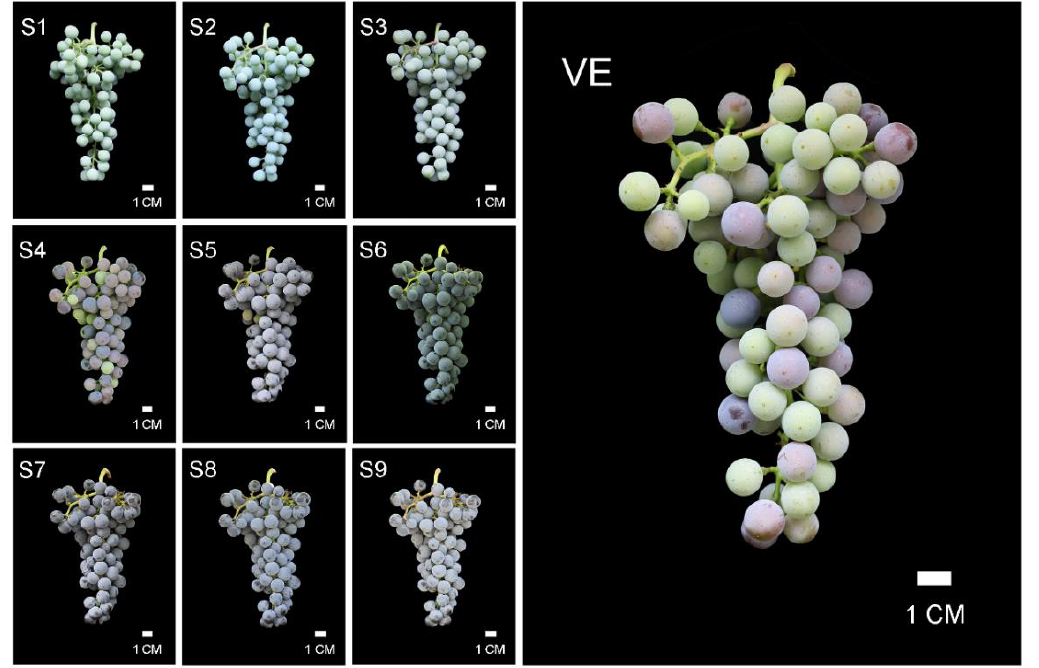
Figure A2. Photos of ‘Beixi’ were taken during sampling time in 2019. S1 – S9 represent the sampling date in 2019, and bar = 1 cm.